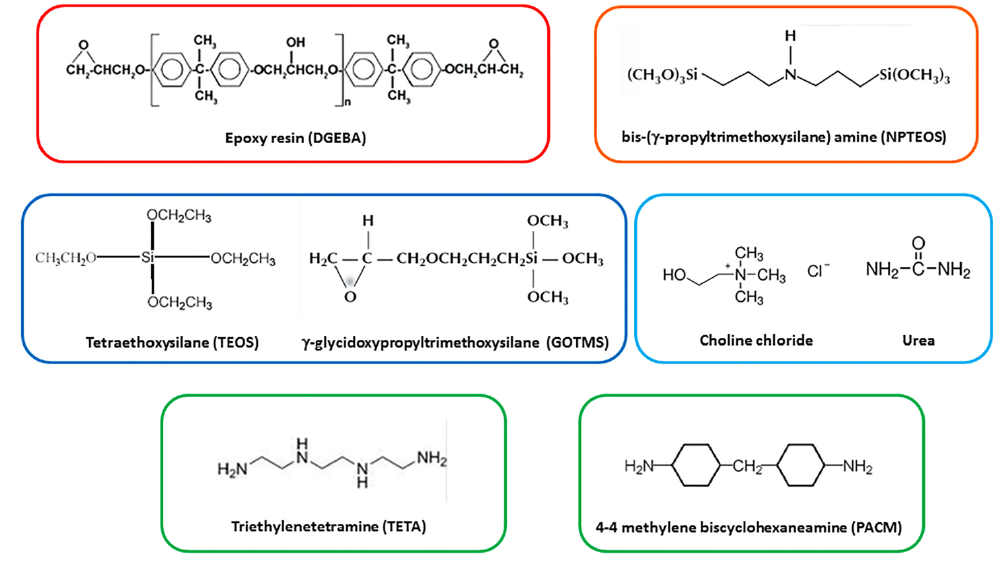
Figure 2. Chemical structure of the materials.